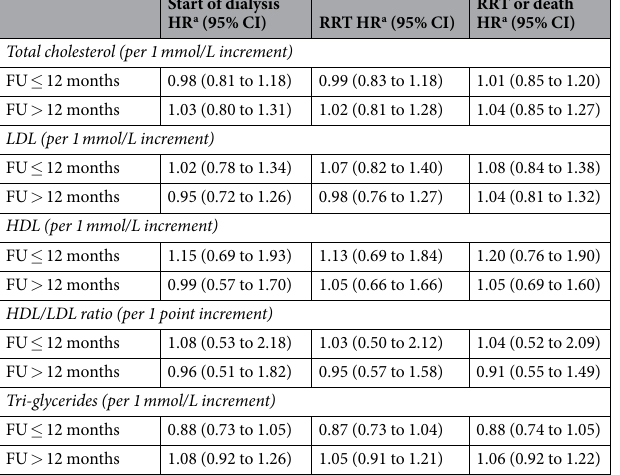
Table 6. Adjusted hazard ratio (95% CI) according to continuous levels of serum lipids or triglycerides for start of dialysis, RRT and combined endpoint after 12 months and after a minimum of 12 months of follow-up. a All analyses were adjusted for: age, sex, ethnicity, current smoker, body mass index, diabetes mellitus, hypertension, proteinuria and primary kidney disease, CRP, Albumin, Subjective Global Assessment, Lipid-lowering medication use. CI: confidence interval, RRT: Renal Replacement Therapy, FU: